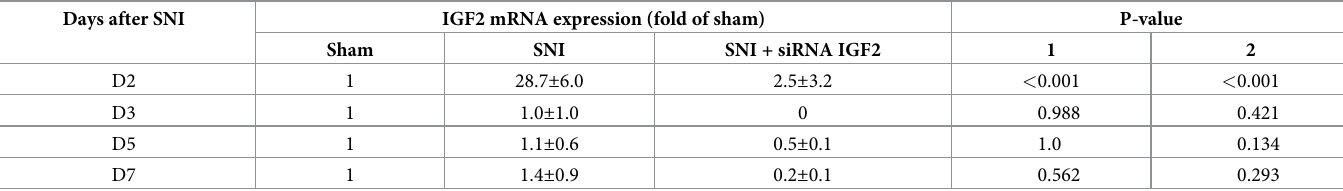
Values are mean ± standard deviation; n = 4; P-value 1: sham group compared with SNI group; P-value 2: SNI + siRNA IGF2 group compared with SNI group. P < 0.05: statistically significant. SNI, spared nerve injury; siRNA, small-interfering RNA; IGF2, insulin-like growth factor-2; BL, baseline; D, day; RT-qPCR, real-time quantitative polymerase chain reaction.